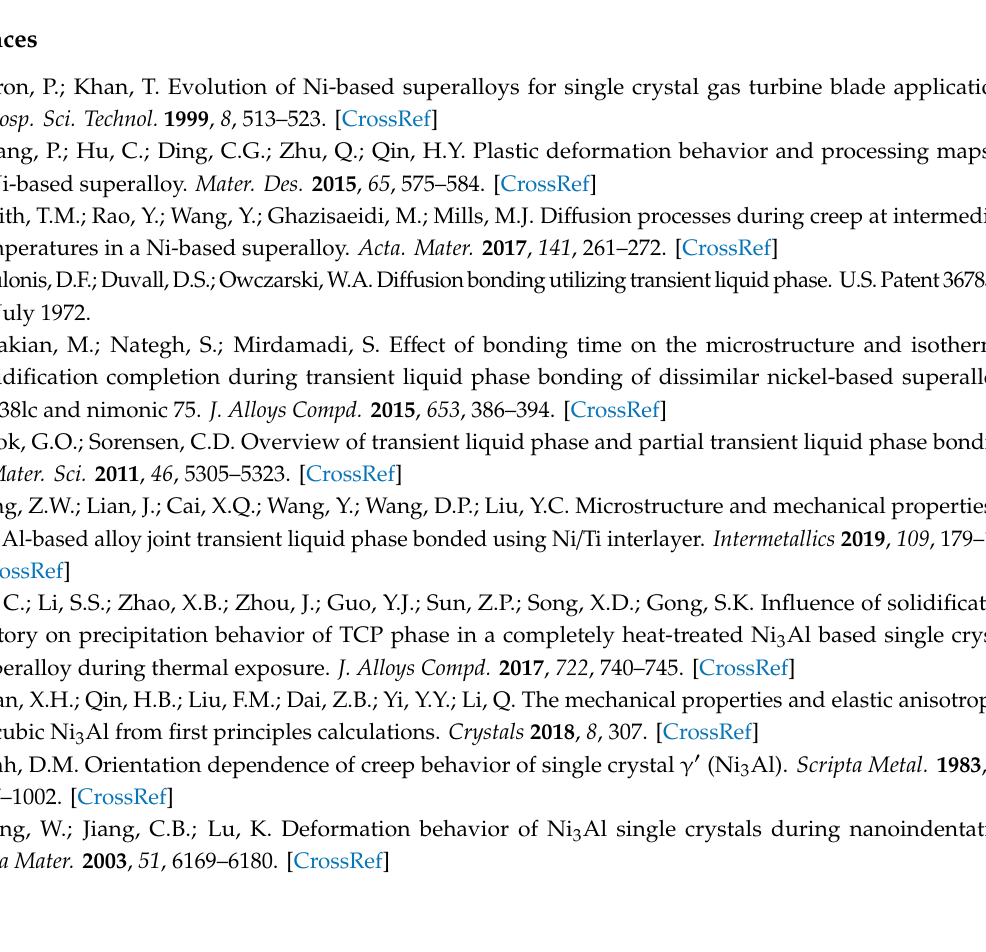
Figure S1: The strain conditions for deriving nine elastic sti ff ness coe ffi cients; Figure S2: Relationship between the average stress and elastic modulus of intermediate layer; Figure S3: The grain boundary and crystal orientation in the TLP bonded joint: (a) SEM-EBSD image of the joint, (b) grain boundary in the joint; (c) all Euler map; and (d) IPF-Y0 map. The instrument used is FEI Quanta 650F + HKL Channel 5; Figure S4: Nanoindentation test: (a) SEM image of a typical zone in TLP bonded joint; and (b) schematic of a location of nanoindentation array (Berkovich indenter, instrument: Agilent G200); Figure S5: The influence of the post weld heat treatment (PWHT) on the elastic modulus (a) and hardness (b) of parent alloy and intermediate-layer alloy; Figure S6: The tensile strengths of TLP bonded joints before and after PWHT (three samples were measured for each point; instrument: universal testing machine, GP-TS2000M); Table S1: The stress in the joint ignoring the crystal orientation of intermediate